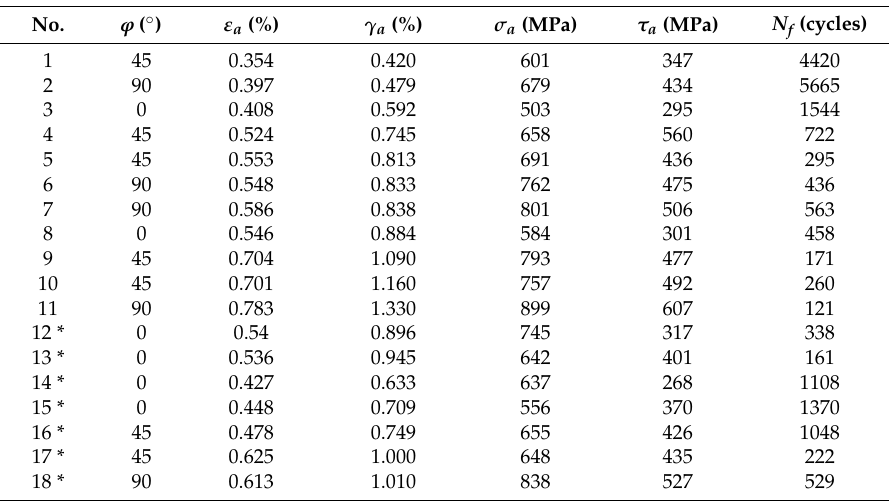
Table 2. Multiaxial fatigue test data for GH4169 at 650 ◦